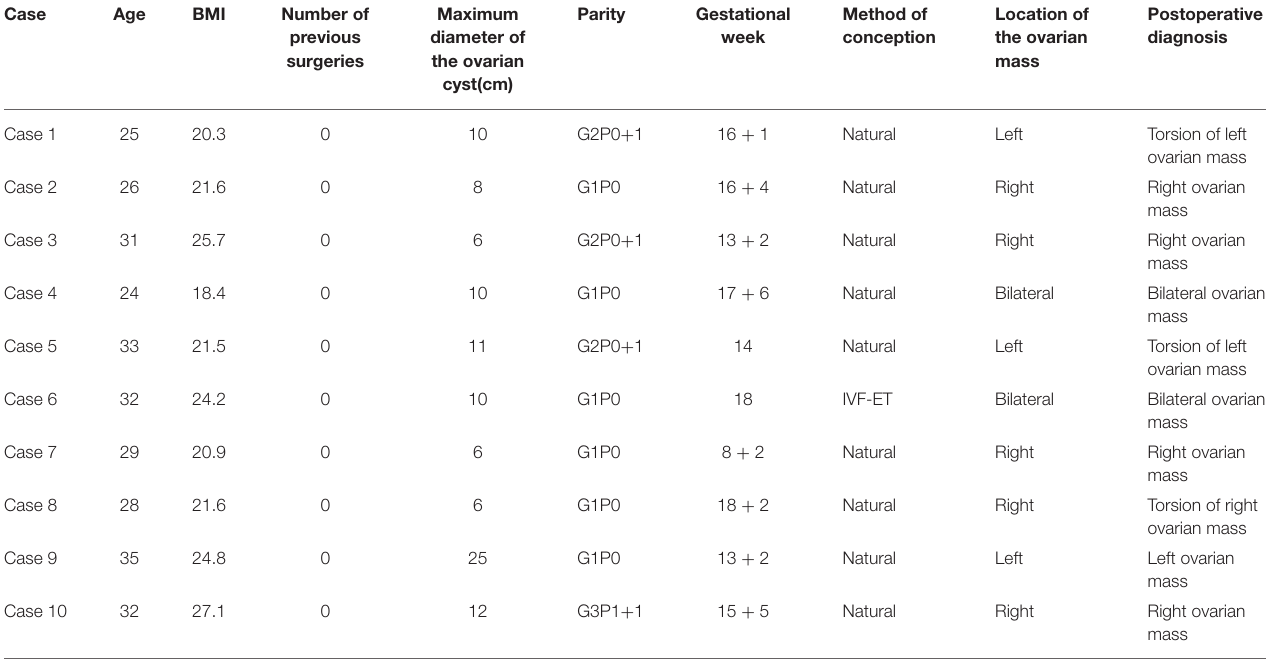
TABLE 1 | Demographic characteristics of the